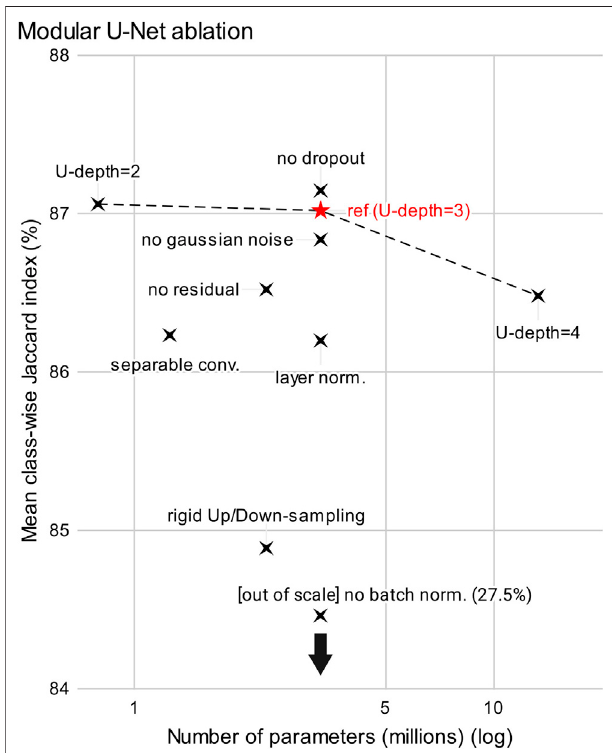
FIGURE 9 | Modular U-Net ablation (2D model). On the x -axis, the number of parameters; on the y -axis the mean class-wise Jaccard indices. Components were removed individually, or replaced by alternatives. Removals: dropout, gaussian noise, residual (skip connection), batch normalization. Replacements: convolutions by separable ones, learnable Down-samplingBlock/Up-samplingBlockbyrigidones( Figure2 ),andbatch normalization by layer normalization. We also compare the effect of the U-depth, i.e., number of levels in the U structure. Notice that the data point no batch norm is out of scale in the y -axis for the sake of